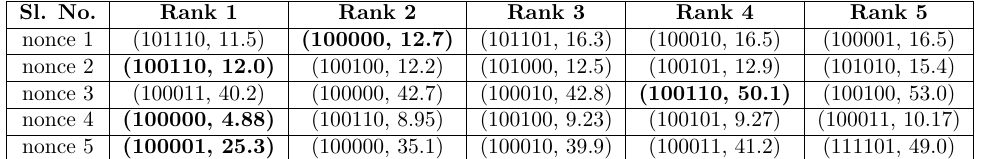
Table 3: Ordering of candidate nonce combinations (6 MSBs) by Least Square Error(LSQ) method. The first element of each tuple represent the candidate nonce and the second element represent the LSQ values( × 10 6 ). The correct combination is marked in bold. Sl. No.